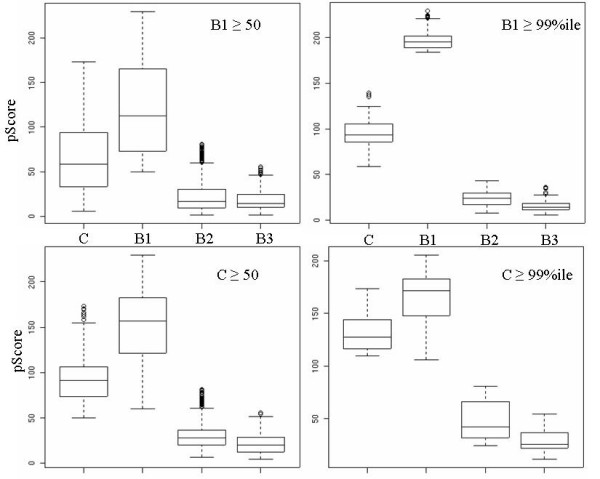
Biases in the parametric binary segmentation method for detection of putative enrichment sites-II. This demonstrates a comparison of site detection in B1-3 and replicate composite(C) based on the threshold selection. Depending on the threshold and which replicate it is determined from, there is significant variation in the detection of putative sites. (Top panel) Detection threshold is determined based on B1 but applied uniformly across B1-B3 and replicate composite (C); (left) Fixed pScore threshold of σp ≥ 50; (right) A distributional threshold of σp ≥ 99th percentile of the pScore distribution. (Bottom panel) Detection threshold is determined based on replicate composite(C) but applied uniformly to all; (left) Fixed pScore threshold of σp ≥ 50; (right) A distributional threshold of σp ≥ 99th> percentile of the pScore distribution.